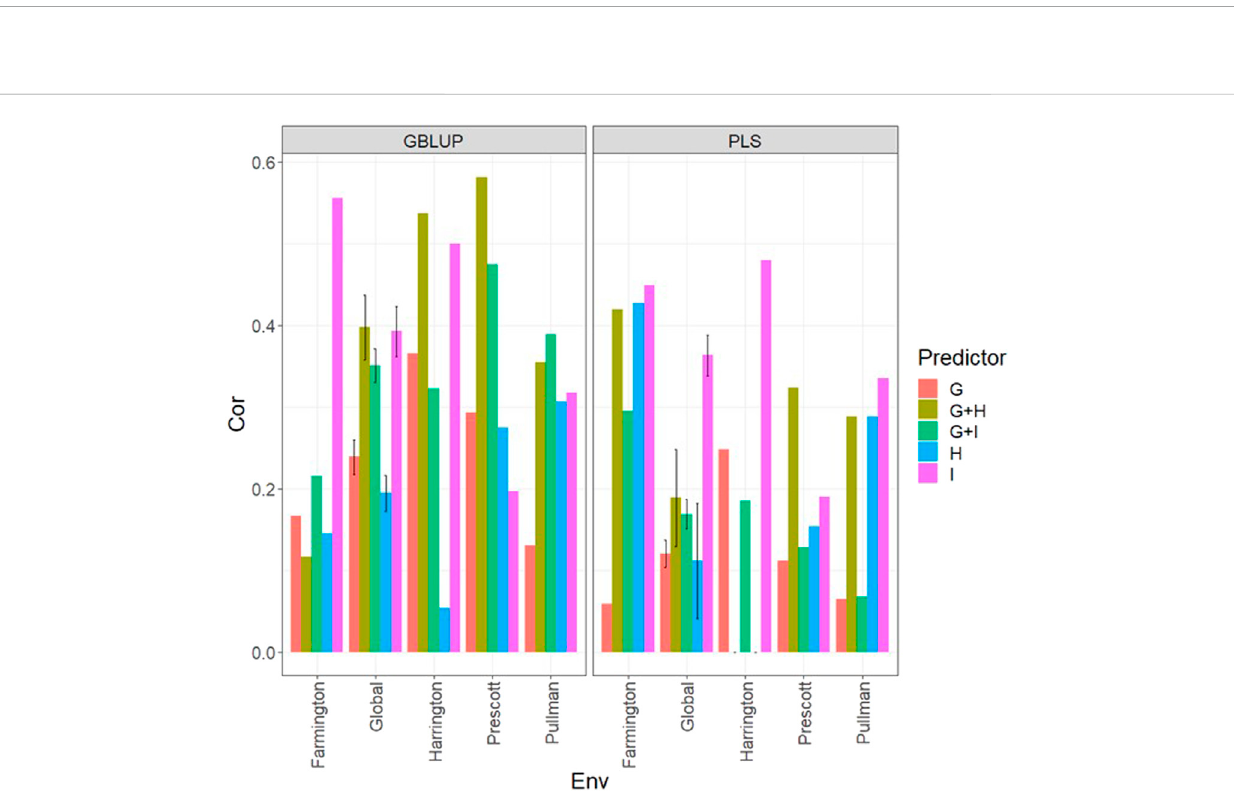
FIGURE 8 Dataset 4 (year 2022). Pearson´s correlation (Cor) and their corresponding Standard Error (SE) for each location and across location (Global) under tested lines in untested environments (LOEO) for nine evaluated predictors under a GBLUP and PLS